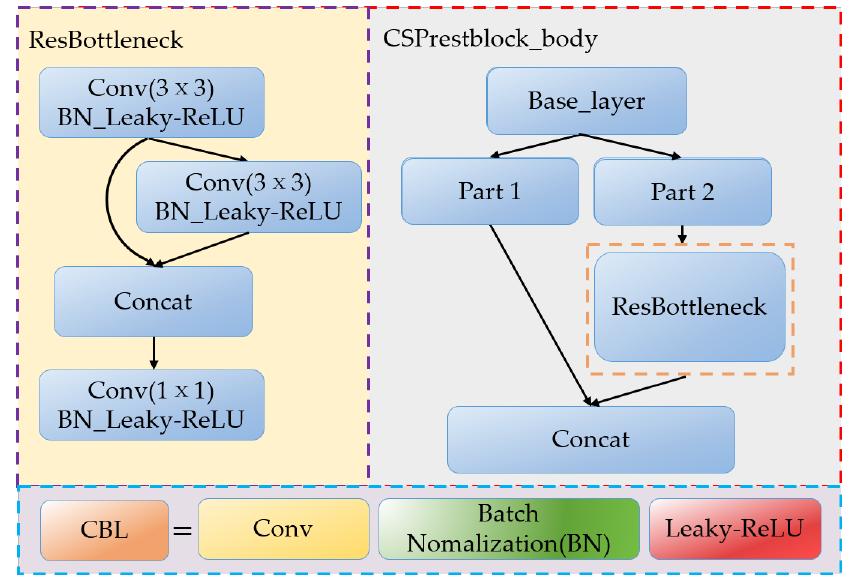
Figure 1. The network structure of CBL and CSPrestblock_body.